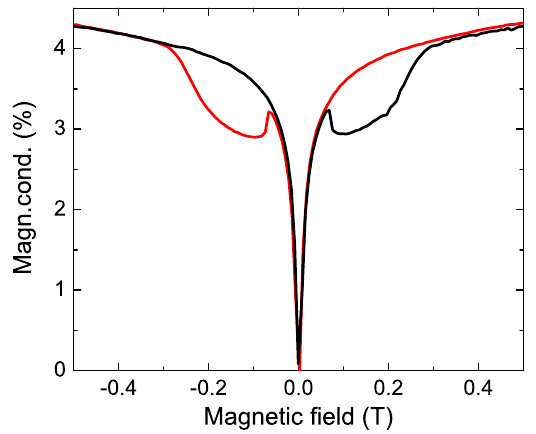
FIG. 5. Magnetoconductivity of devices with an inorganic metallic electrode. The device structure consists of a ferromag- netic bottom electrode, a 38-nm ITO layer, a 40-nm Alq 3 , a Ca layer, and an Al layer. The domain structure of this ferromag- netic electrode is similar to that employed in the device reported in Fig.